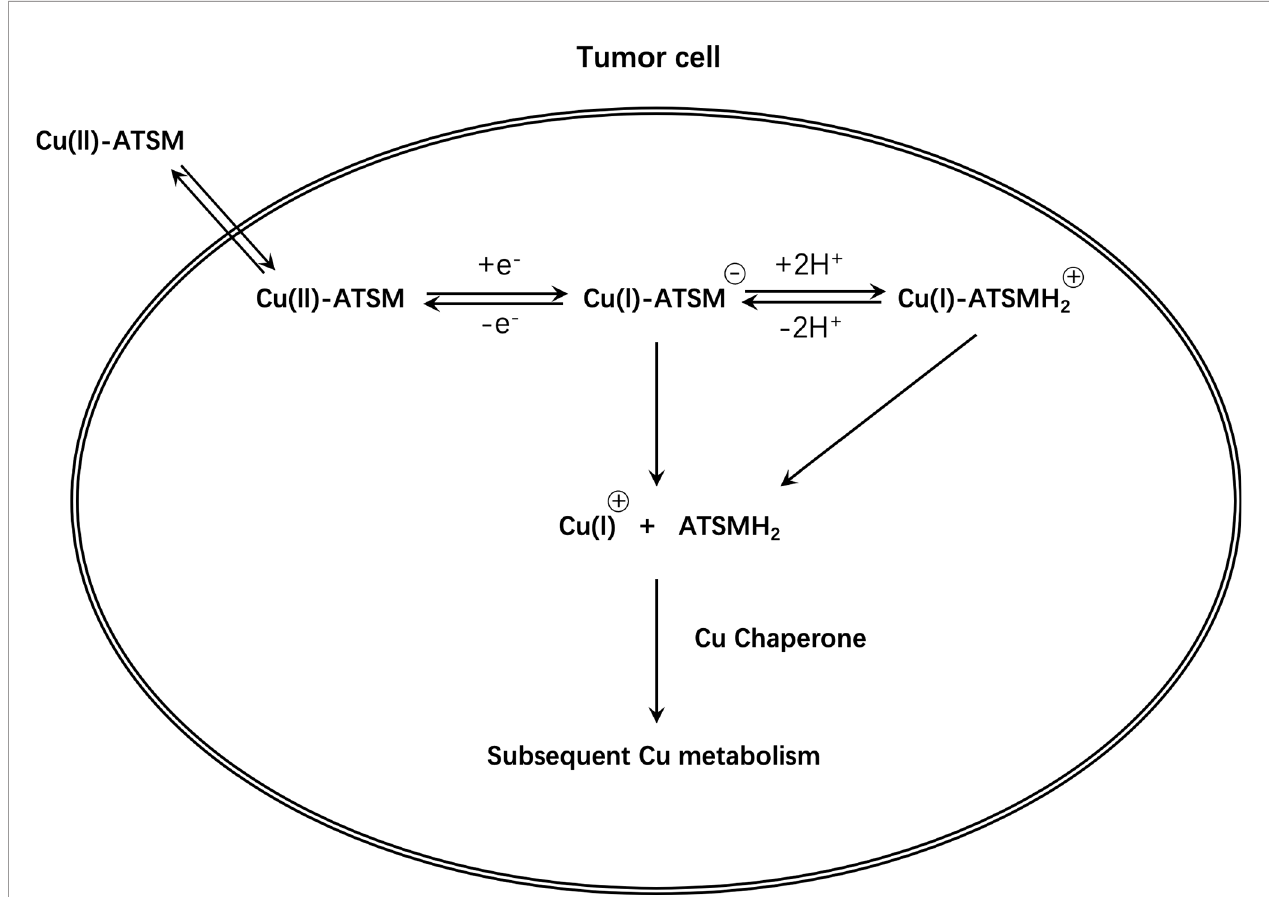
FIGURE 6 | Schematic diagram of Cu-ATSM retention